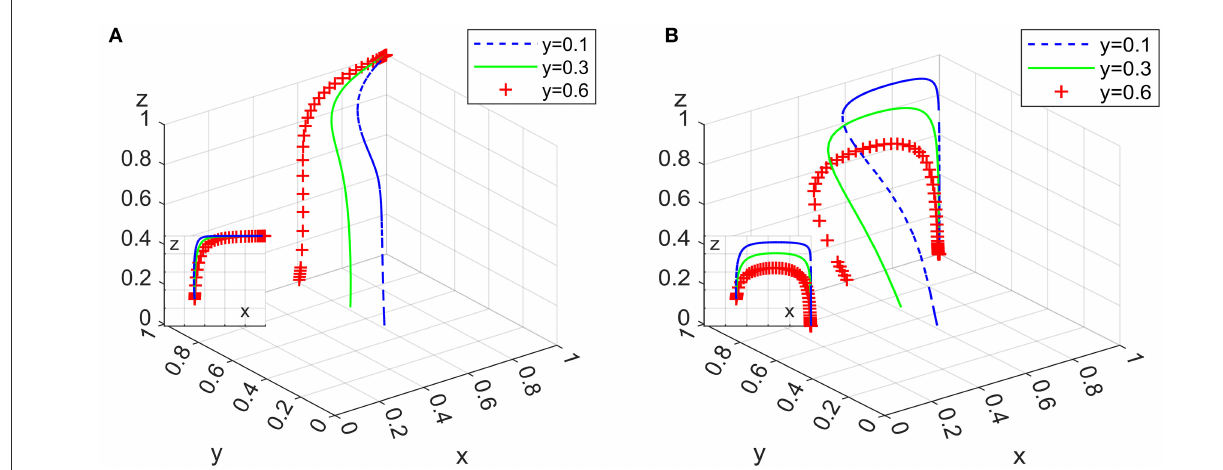
FIGURE7 Impact of domestic enterprises’ strategies in system L (A) and system P (B) .